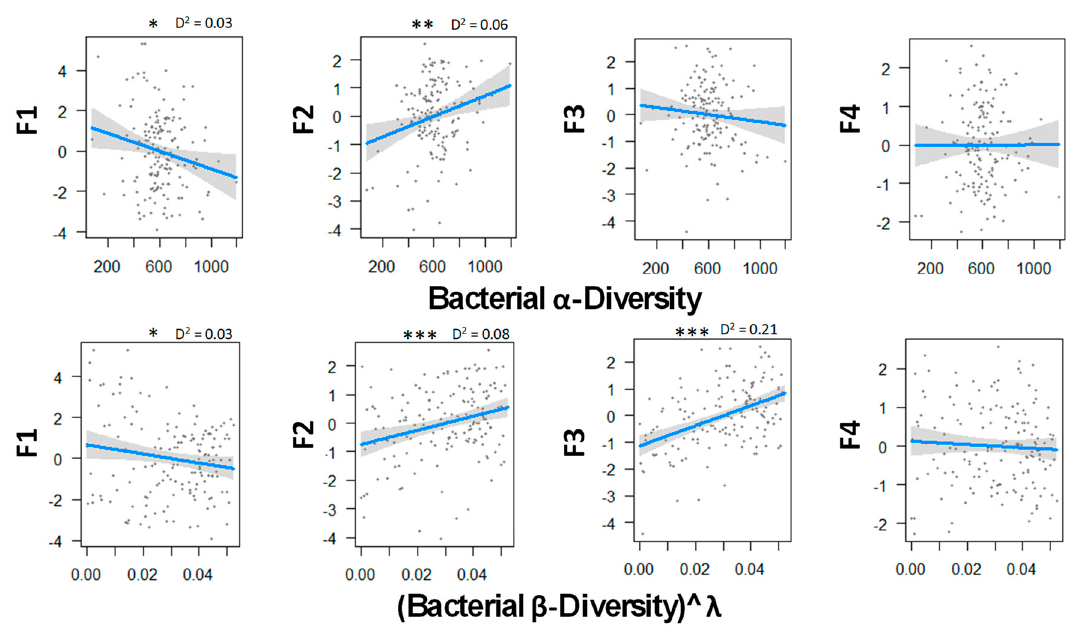
Figure 3. Relations between bacterial α and β biodiversity and the ecosystem functions analyzed by GLM and a Gaussian law grouped with PCA axes. Transformation parameter λ was equaled to 2.45 for fungal β -diversity. Thresholds of significance are as follows: 0 '***' 0.001 '**' 0.01 '*' 0.05 '.' 0.1 '' 1. D 2 represents the adjusted amount of deviance for GLM ( Dsquared function in modEvA package v1.3.2). Bacterial diversity explains best the primary productivity and soil microbial biomass (F2) and the N cycle (F3) with 8.0% and 21.0% of the variance, respectively. n = 156 .